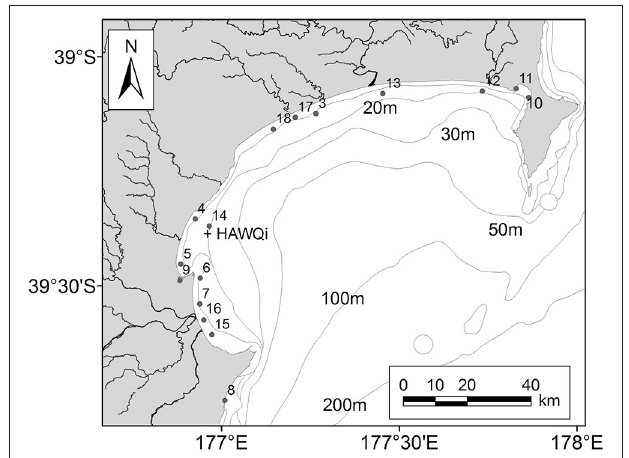
FIGURE 3 | Moored data site of the Hawke Bay water quality information monitoring buoy (HAWQi; + ), and State of the Environment (SOE; dots) water sampled sites (3–18) used in this study. Bathymetric depth contours also shown (gray lines).